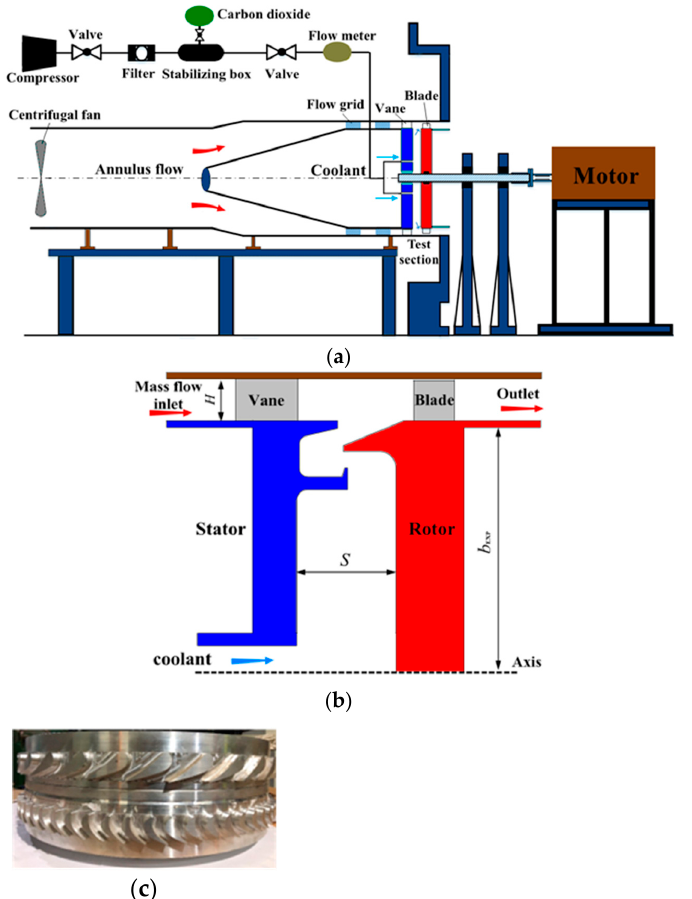
Figure 6. Experimental system in the present study: ( a ) experimental system; ( b ) test section; ( c ) and experimental rig.